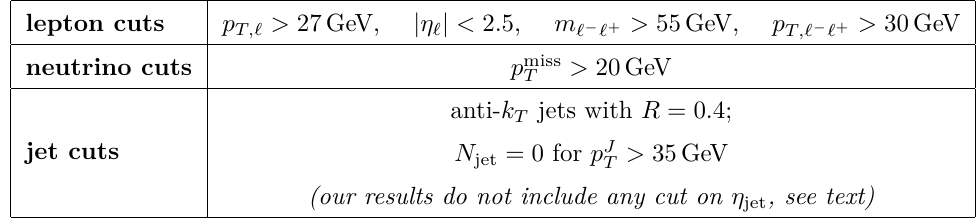
√ (cid:0) 1 − m 2 (cid:1) /π and the mixing angle cos θ 2 2 G m 2 /m 2 F W W Z